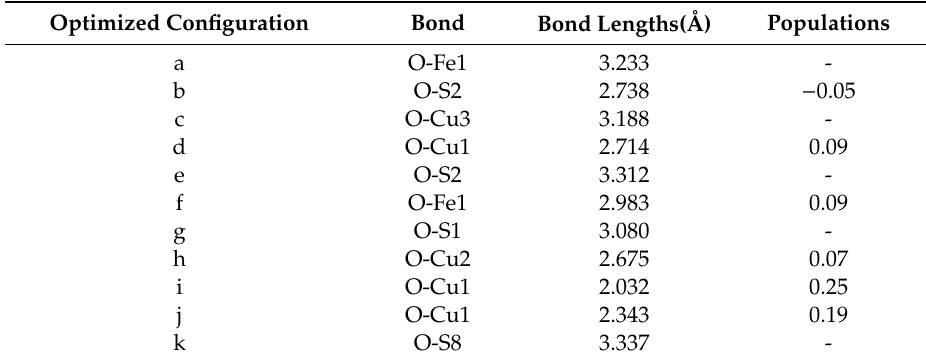
Figure 7. Optimized configurations of adsorbed glucose on the chalcopyrite (0 0 1) surface. ( a – f ), single hydroxyl of glucose adsorbs on the Fe, S, Cu, S defect, Fe defect and Cu defect sites; ( g – k ), polyhydroxyl of glucose adsorbs on top, hollow, S defect, Fe defect and Cu defect sites, respectively. Table 4. Bond Lengths and Mulliken bond